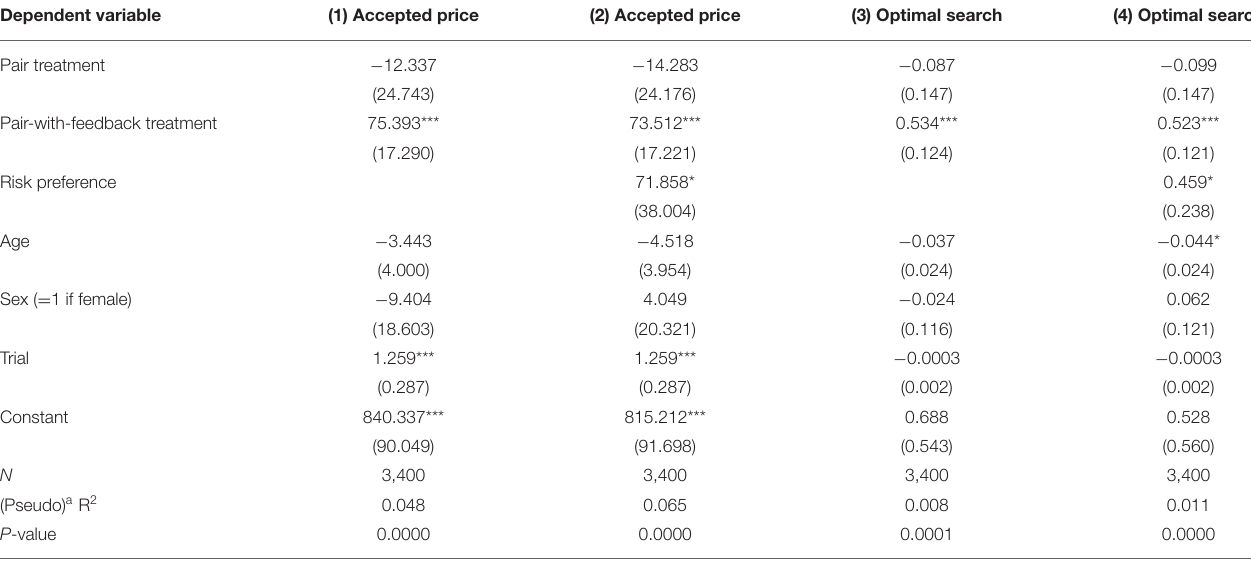
TABLE 3 | Regression results for search